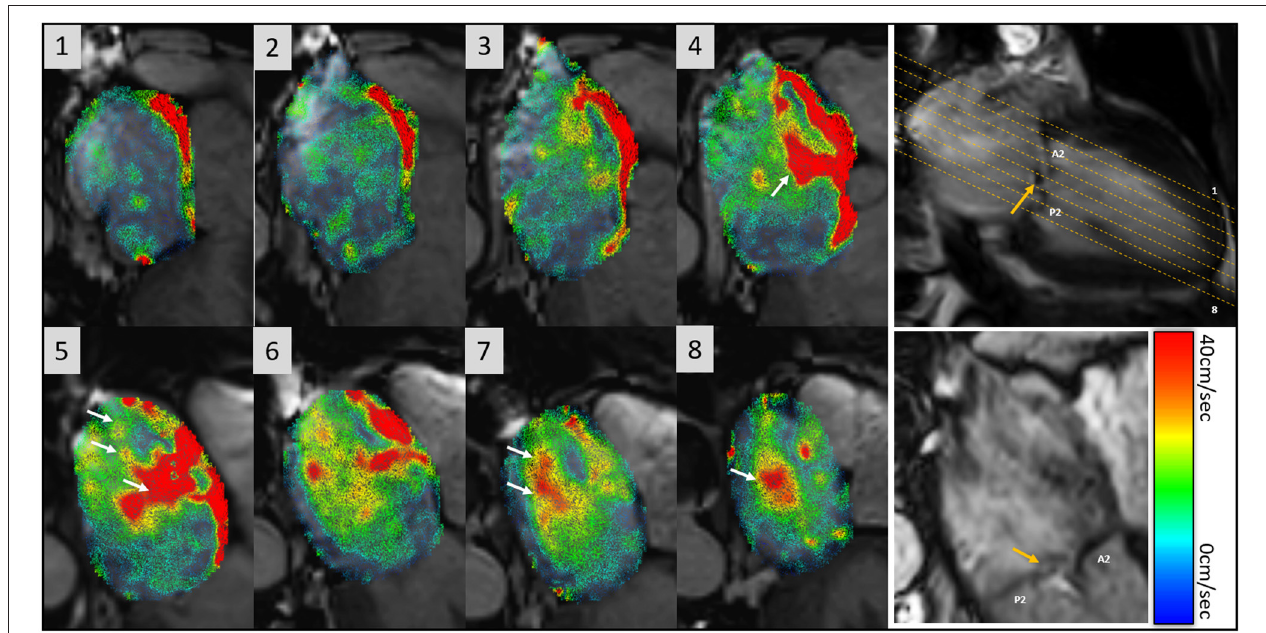
FIGURE 7 | Overview of flow visualisation in the left atrium in a patient with mitral regurgitation secondary to P2 prolapse (orange arrow). 4D flow data is co-registered with cines to demonstrate 2-directional vectors, which have speed encoded colour coding (0–40 cm/s). There is eccentric mitral regurgitation that is directed towards the intra-atrial septum and swirls back into the left atrium (white arrows in panels 4–8). The mitral regurgitation jet almost fills the entire left atrium.